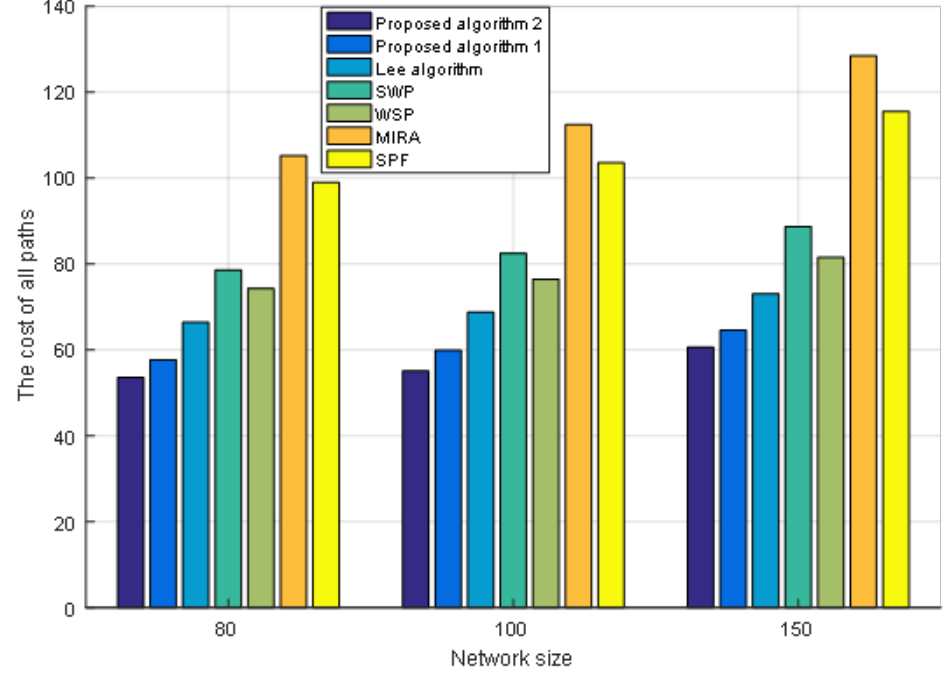
Figure 7. The cost of all paths under different network